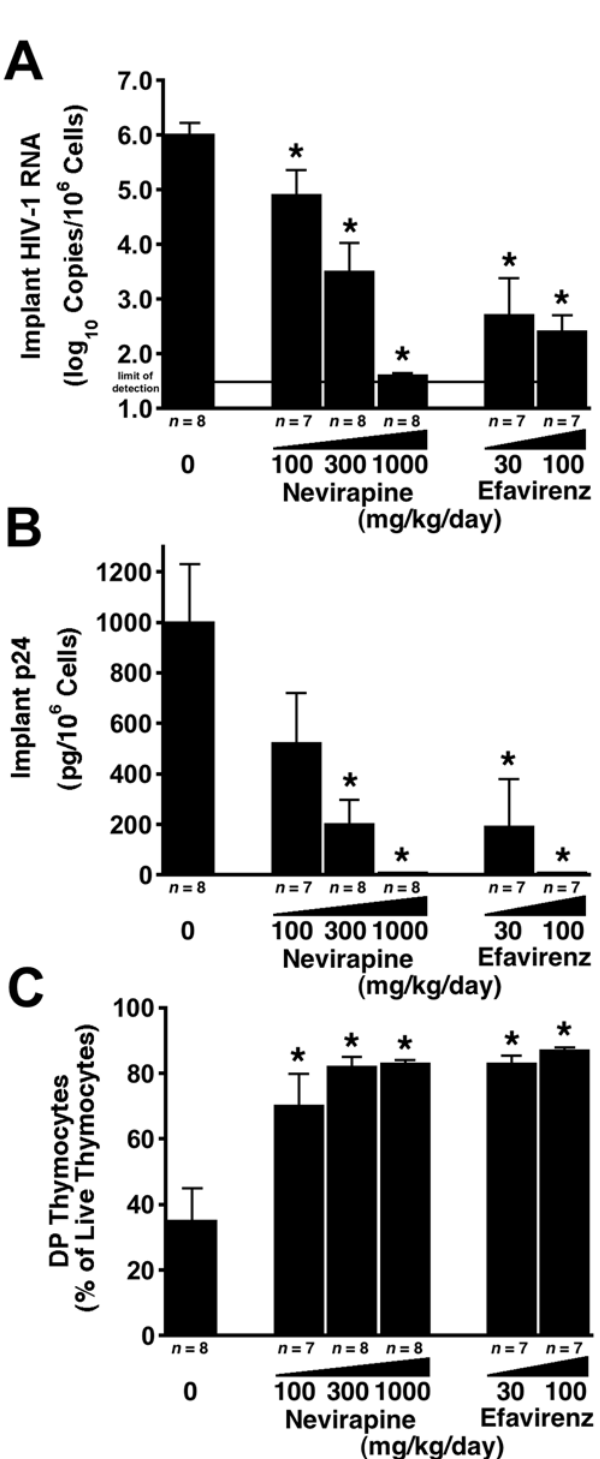
Figure 5. Efavirenz is more potent than nevirapine against HIV-1 NL4-3 in SCID-hu Thy/Liv mice. Mice were treated by twice-daily oral gavage with nevirapine or efavirenz at the indicated dosage levels beginning on day 2 1. Antiviral efficacy was assessed by determining HIV-1 RNA (A) and p24 (B), and thymocyte protection was assessed by percentage of DP thymocytes (C) (means 6 SEM). *p # 0.05, compared with untreated mice for the number of mice indicated under each bar.